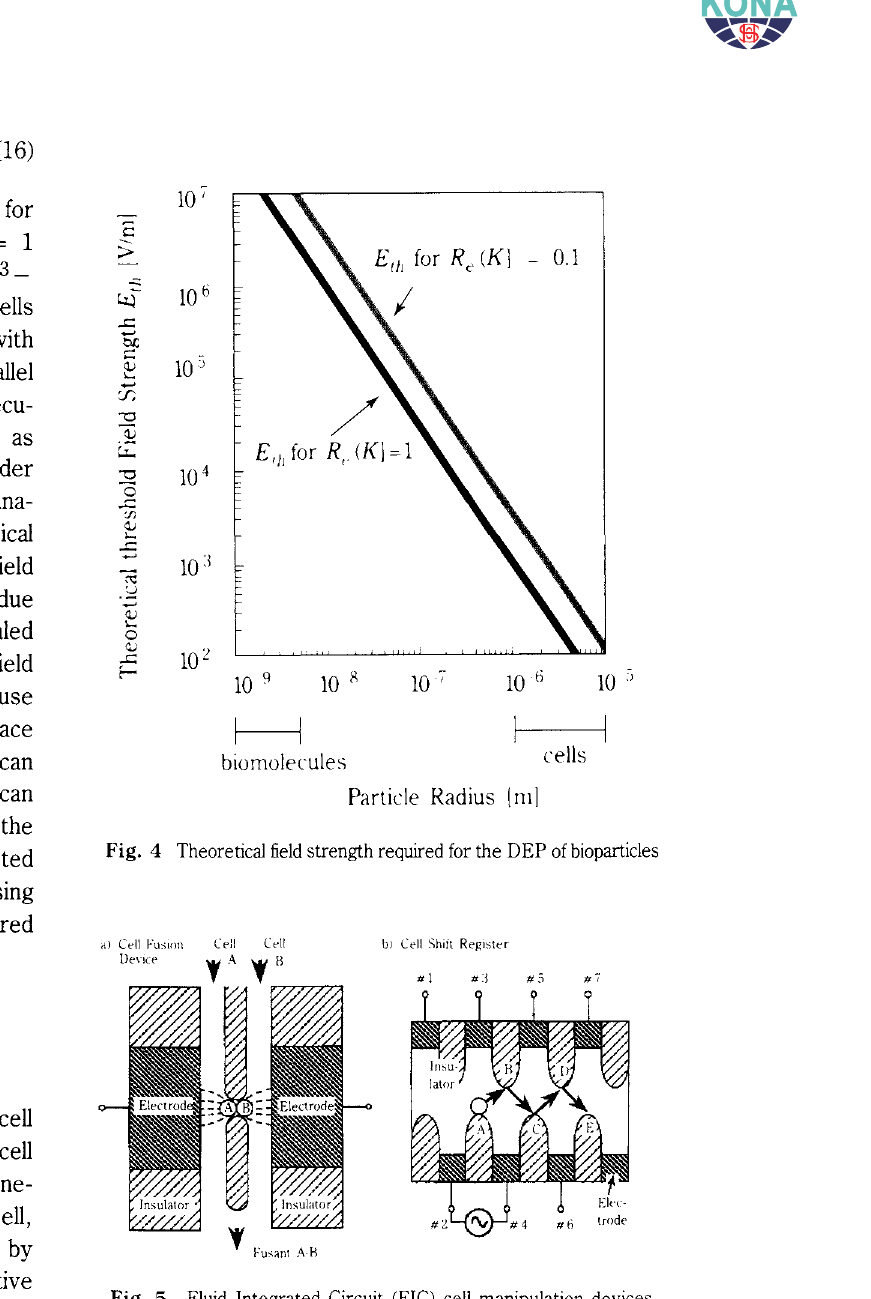
Fig. 5 Fluid Integrated Circuit (FIC) cell manipulation devices fig., which creates field maximum at the tip of A. The cell is dielectrophoretically attracted and trapped here. Then the voltage between # 2 and # 4